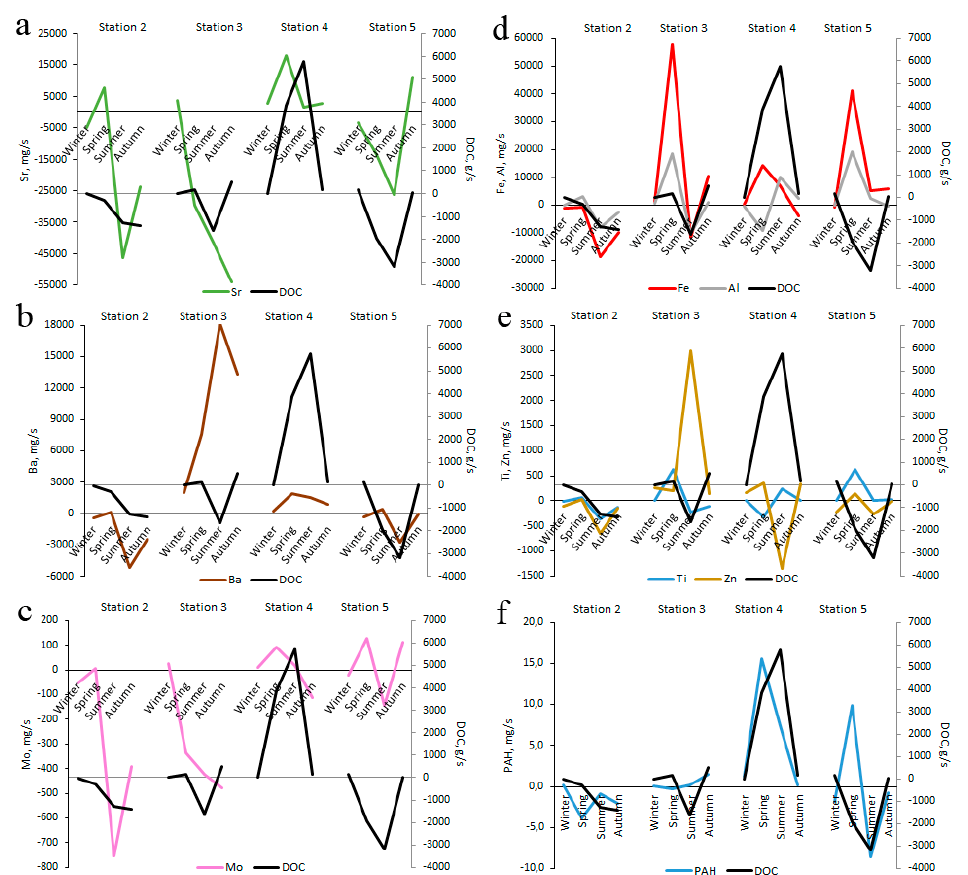
Figure 3. Spatial and temporal variation in the removal rates of elements that are moderately correlated and uncorrelated with DOC. ( a ) Sr, ( b ) Ba, ( c ) Mo, ( d ) Fe, Al, ( e ) Ti, Zn, ( f ) PAH. The temporal patterns of removal/release of metals uncorrelated with DOC such as Al, Fe (Figure 3d), Ti, and Zn (Figure 3e) are similar to those of the solutes correlated with DOC, although the rate of release of these metals is much higher than the rate of their removal at all stations except upper station 2. The low removal rates of Al, Fe, Ti, and Zn are likely caused by the organic